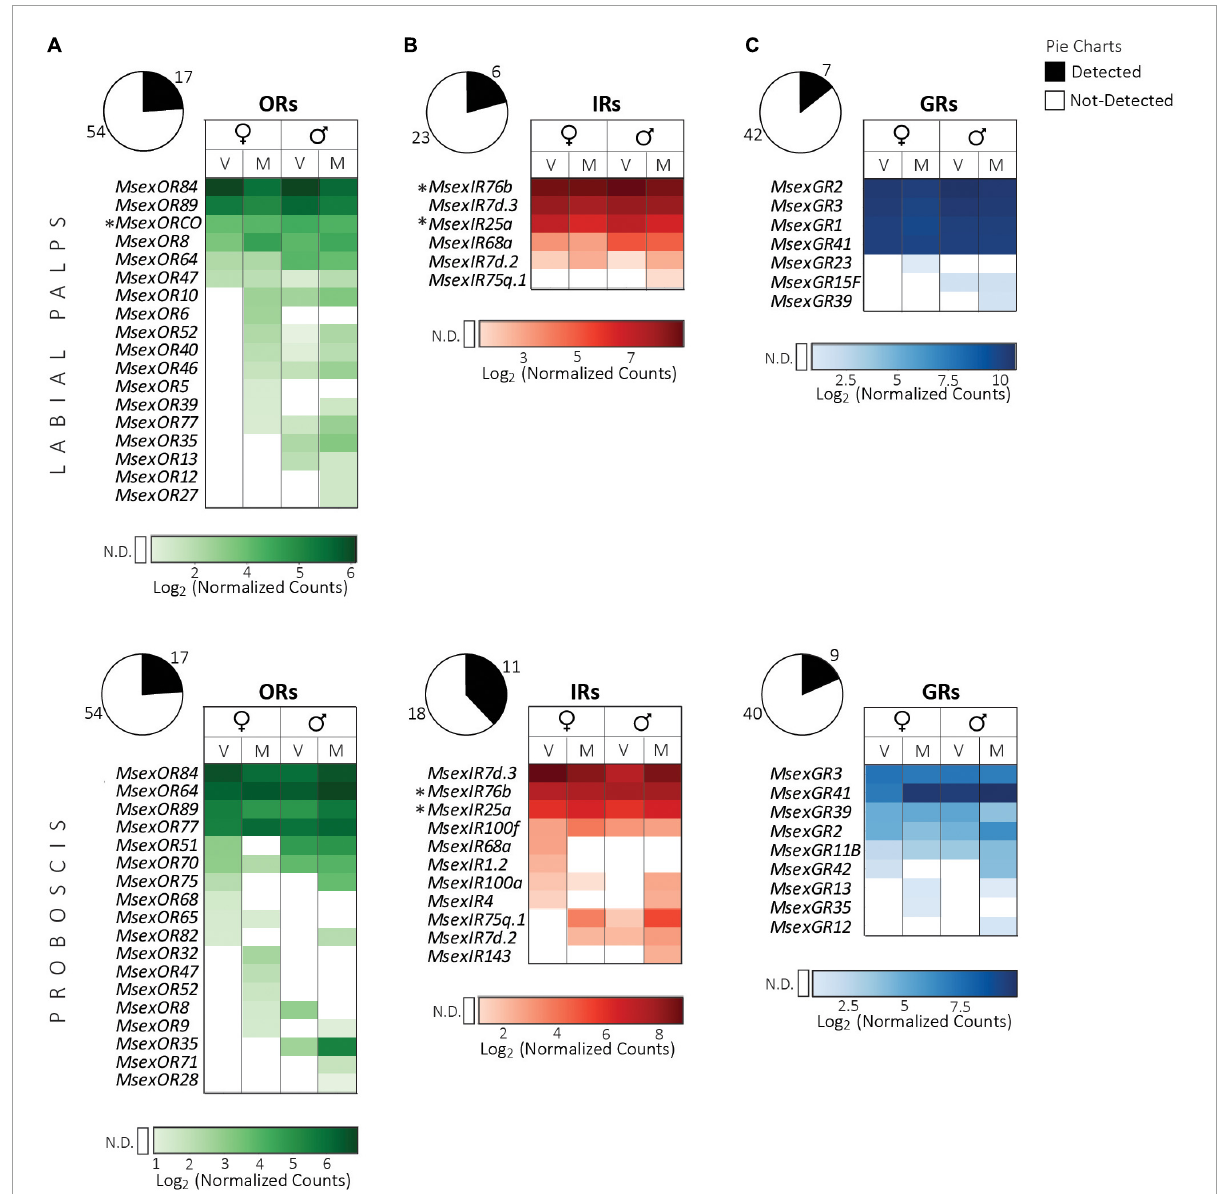
FIGURE2 Expression of chemosensory receptor genes in the mouthparts (top panel, labial palps; bottom panel, proboscis) of adult M. sexta . (A) Odorant receptors, (B) ionotropic receptors, (C) gustatory receptors. Pie charts depict the percentage of expressed genes (absolute numbers next to the charts) of each receptor family (see legend on top right). Heatmaps were created separately for each receptor family using the log 2 of the geometric mean ( n = 3 biological replicates) of normalized counts obtained from the NanoString assay (see section “Materials and methods”). Light to dark shades indicate low to high counts (see color bar at bottom of each heatmap); white cells indicate no detection (N.D.) of transcripts (for a definition see section “Materials and methods”). Columns represent female and male moths of different mating states (V: virgin, M: mated). Rows represent receptors that were expressed in the mouthparts of at least one of the four groups, and are sorted first according to values in virgin females, followed by mated females, virgin males and mated males. Symbols next to receptor gene names: *, OR or IR co-receptors. Sex and mating states of males and females did not have a significant effect on receptor gene expression (FDR corrected p > 0.05, nested ANOVA).